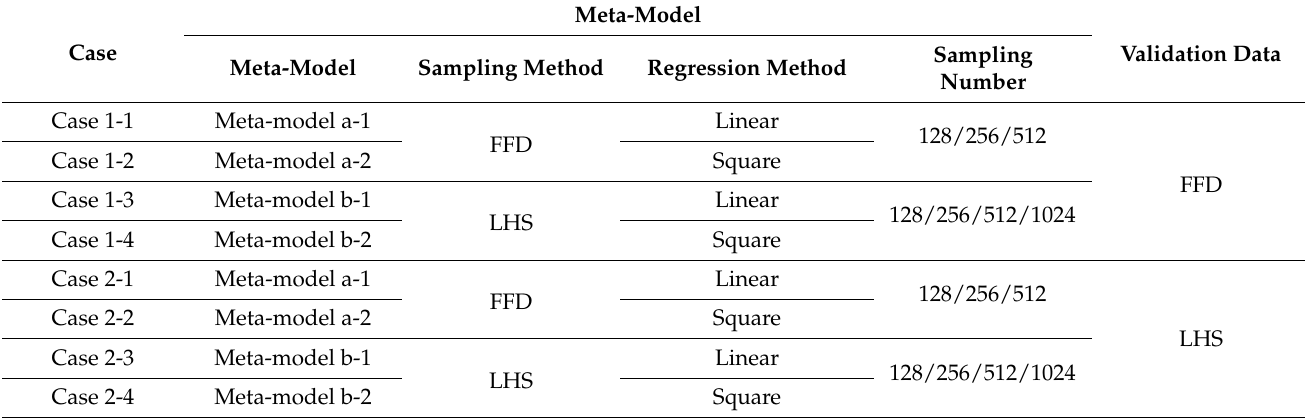
Table 4. List of cases considered to compare the accuracy of FFD and